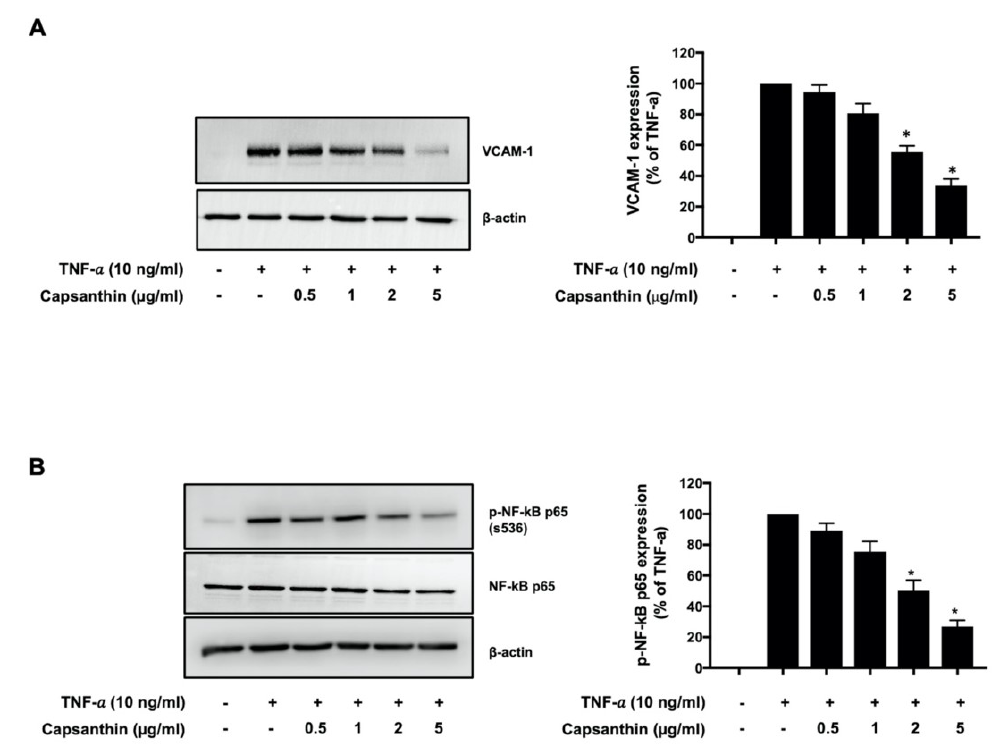
Figure 1. Capsanthin inhibited tumor necrosis factor − α (TNF − α ) − induced vascular cell adhesion molecule 1 (VCAM − 1) expression and nuclear factor − κ B (NF − κ B) p65 phosphorylation in human umbilical vein endothelial cells (HUVECs). ( A ) Immunoblot analysis for VCAM − 1 expression using cell lysate from TNF − α − treated HUVEC for 12 h following pre-treatment with capsanthin (left). β − actin was used as a loading control for VCAM − 1. The bar graphs represent the quantitative difference in the expression of VCAM − 1 (right). ( B ) Immunoblot analysis for NF − κ B p65 phosphorylation (ser536) using cell lysate from TNF − α − stimulated HUVEC for 6 h following pre-treatment with capsanthin (left). NF − κ B p65 and β − actin were used as loading controls for NF − κ B p65 phosphorylation. Bar graphs represent the quantitative difference in the expression of NF − κ B p65 phosphorylation (right). All values represent the mean ± standard error of the mean (SEM) ( n = 3). * p < 0.05 vs. TNF- α -induced